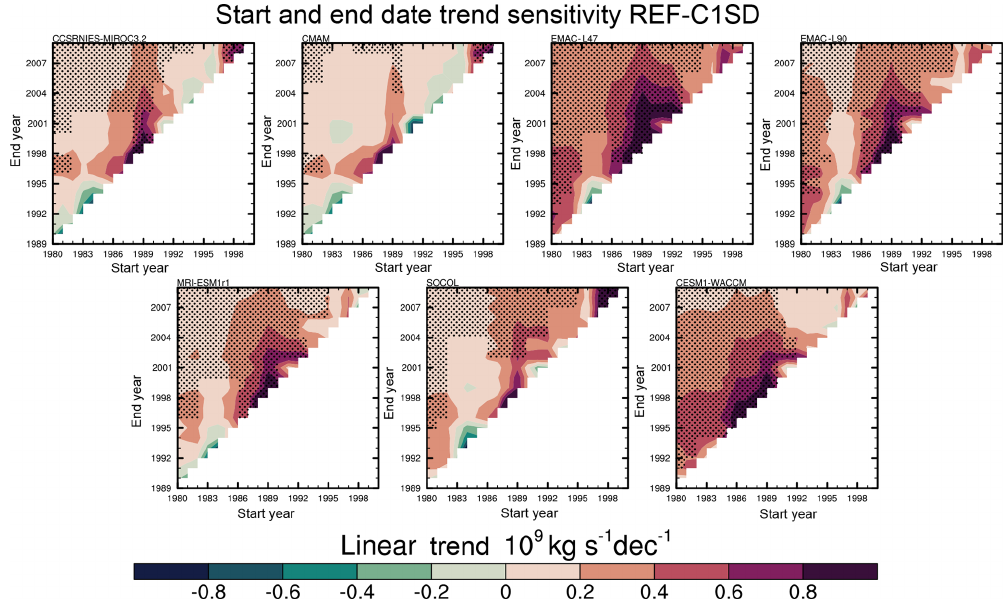
Figure 13. As in Fig. 12 but for the REF-C1SD